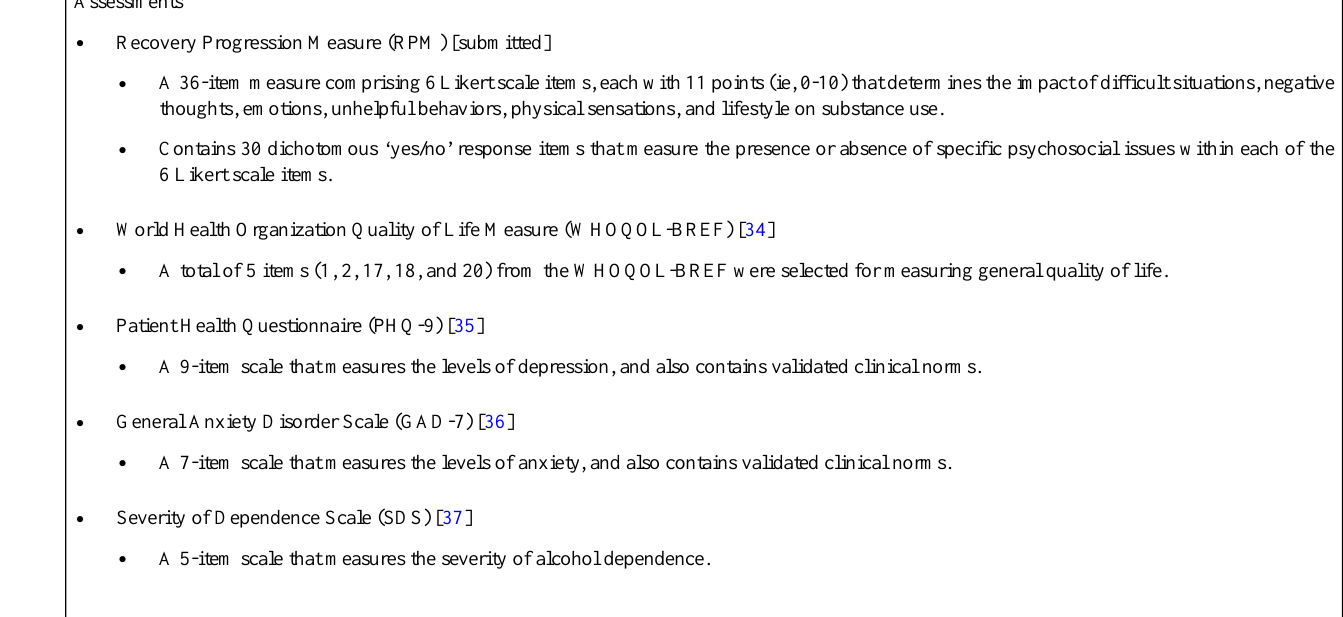
Textbox 1. Baseline assessments of the BFO program.